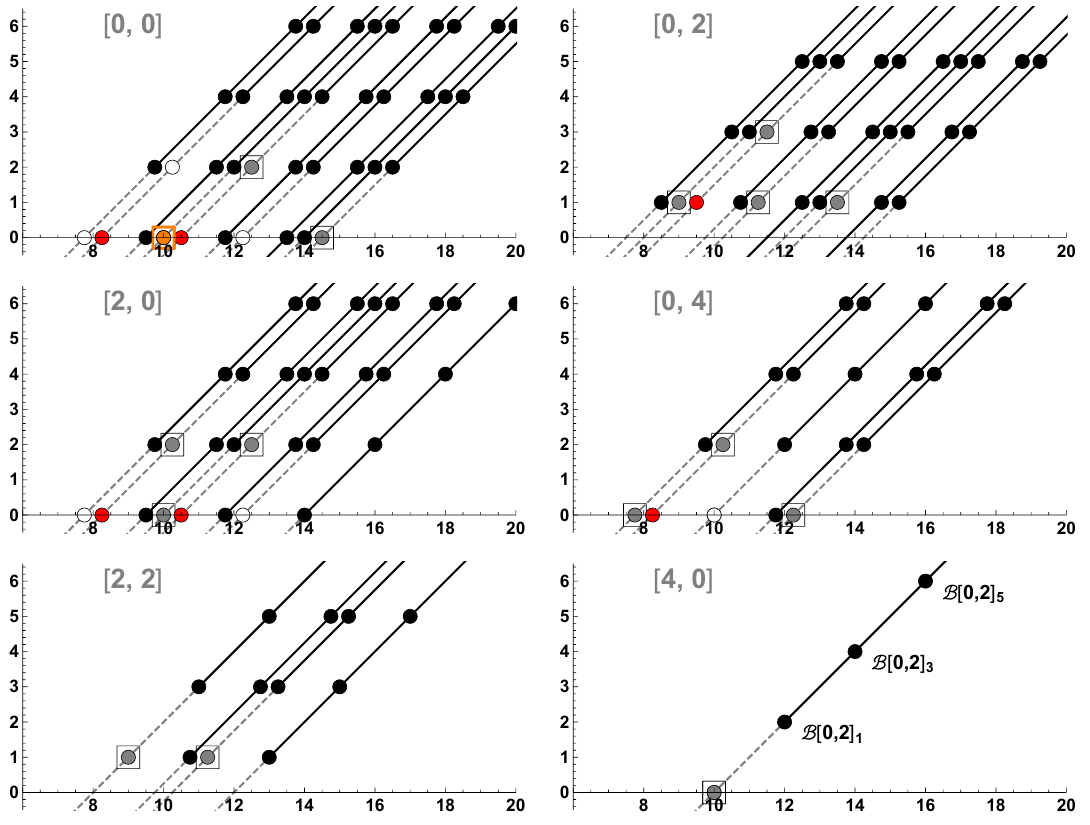
Figure 2. (∆ , ‘ ) planes: B [0 , 2] ‘ − 1 trajectories (lines and dots) and D [0 , 4] operators (squares).